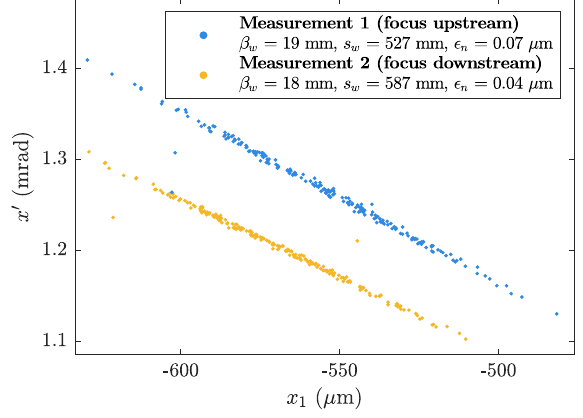
FIG. 4. Measured jitter phase spaces at the location of the upstream BPM for two different optics settings, indicating cm- scale waist beta functions focused at two waist locations 60 mm apart. A small distortion from a finite BPM resolution was taken into account when calculating the jitter parameters. These measurements should be compared to the corresponding quadru- pole scans in Fig. 5. Each dataset consists of 210 shots, giving an estimated relative error of